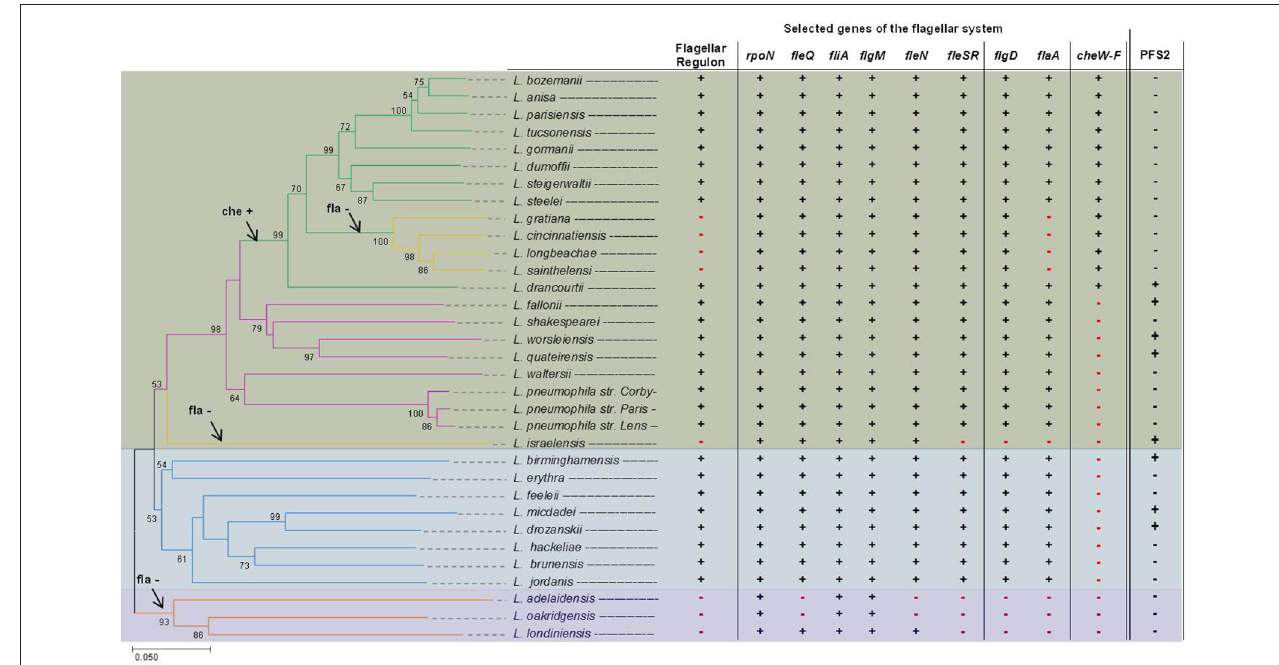
FIGURE 3 | Evolutionary relationships of Legionella species and distribution of flagellar regulon and chemotaxis genes. Shown is a phylogenetic tree of Legionella spp. based on the fliA gene (left side) and also the distribution of flagellar regulon and chemotaxis genes (right side). The phylogenetic tree was reconstructed on the basis of the fliA gene using the Neighbor-Joining method (Saitou and Nei, 1987) and a bootstrap of 1,000 (Felsenstein, 1985). The bootstrap > 50 is reported next to the branches. The phylogenetic distances were computed using the Tamura-Kumar method (Tamura and Kumar, 2002) and refers to the units of the number of base substitutions per site. For the evolutional analysis, performed in MEGA7 ( Kumar et al., 2016), position containing gaps and/or missing data were eliminated. To determine whether selected genes belonging to the flagellar regulon and chemotaxis genes are present among investigated Legionella , an in silico BLAST search was performed using Legionella draft genomes recently published by Burstein et al. (2016). The complete structure of genes of the flagellar regulon of L. pneumophila strain Corby, L. longbeachae , L. israeliensis , and L. oakridgensis are given in Figure 5 . Data for L. pneumophila strains were taken from Cazalet et al. (2010), Glockner et al. (2008), and Albert-Weissenberger et al. (2010). Legionella clade I is highlighted in green, clade II in blue and clade III in purple. On the left, in the phylogenetic tree, possible time points when the flagellin gene ( flaA ) and the chemotaxis ( che ) genes were lost (–) or acquired ( + ) are indicated with arrows. On the right, the presence ( + ) and/or absence (–) of selected genes belonging to the flagellar regulon, the chemotaxis operon or an operon encoding a putative second flagellum or a putative T3SS (PFS2, based on unpublished data ) are indicated,